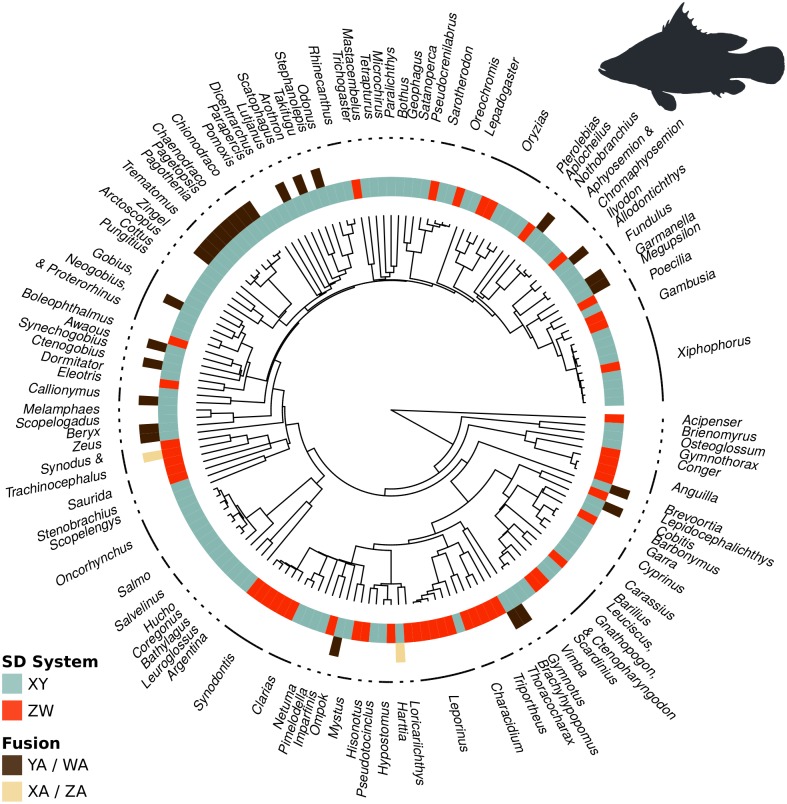
Sex chromosome fusions (outer circle) and sex determination system (inner circle) mapped onto the phylogenetic tree of fishes.The vast majority of fusions occur in XY systems (aqua) and involve Y-A fusions (brown).